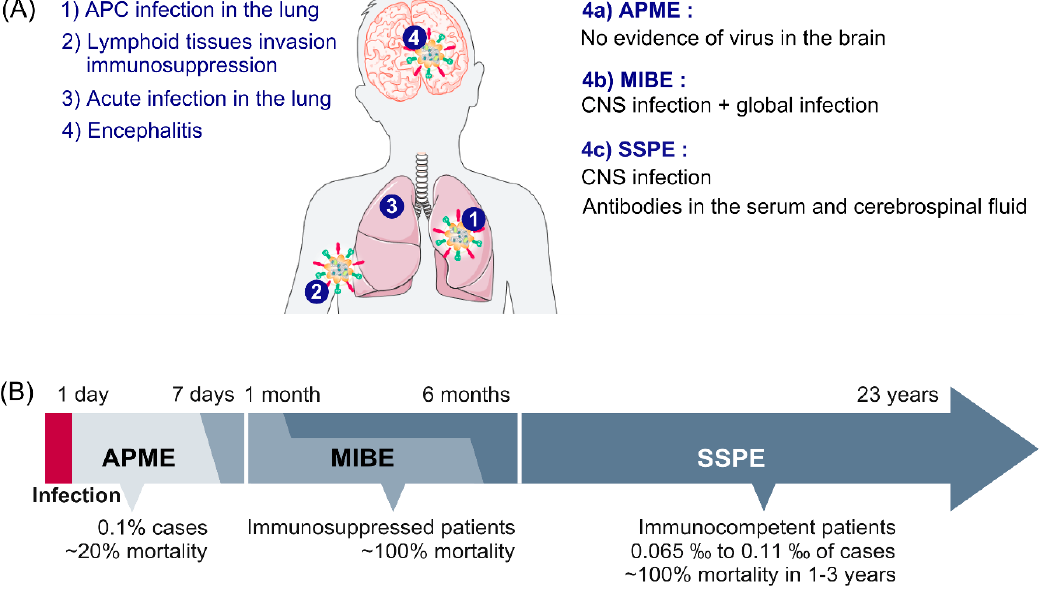
Figure 2. Course of MeV infection leading to measles encephalitis. ( A ) Initially, MeV infects myeloid cells in the respiratory tract. Then, MeV-infected lymphocytes disseminate the infection via the lymphatic and vascular systems. As a consequence of transient immunosuppression or autoimmunity, patients can develop acute post-infectious measles encephalitis (APME) shortly after exposure without systematic central nervous system (CNS) infection. However, measles inclusion-body encephalitis (MIBE) and subacute sclerosing panencephalitis (SSPE) are associated with MeV infection of the CNS. ( B ) The occurrence of MeV encephalitis may range from one day to 15 years following initial infection.